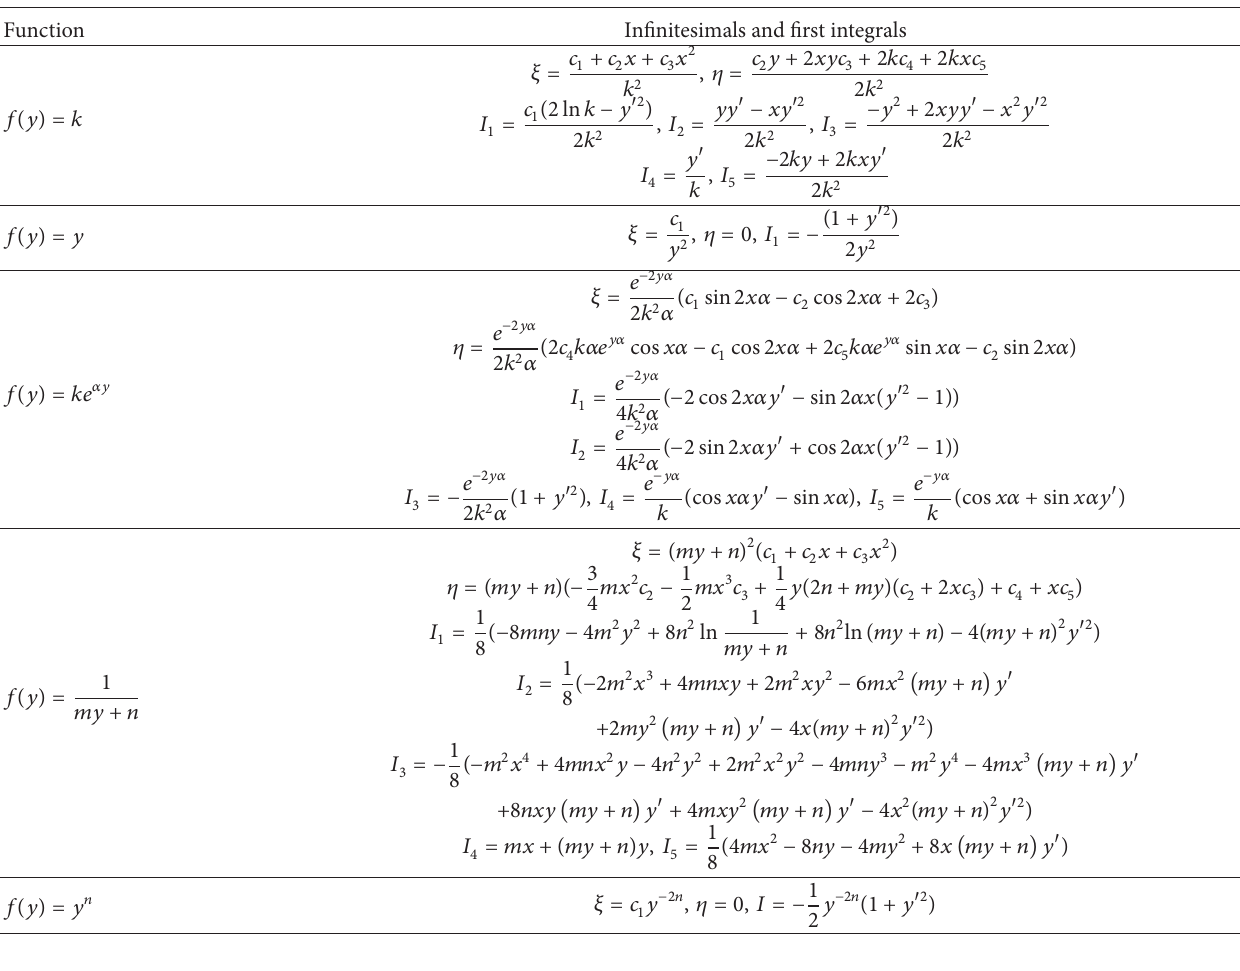
Table 1: Noether symmetry classification table of path